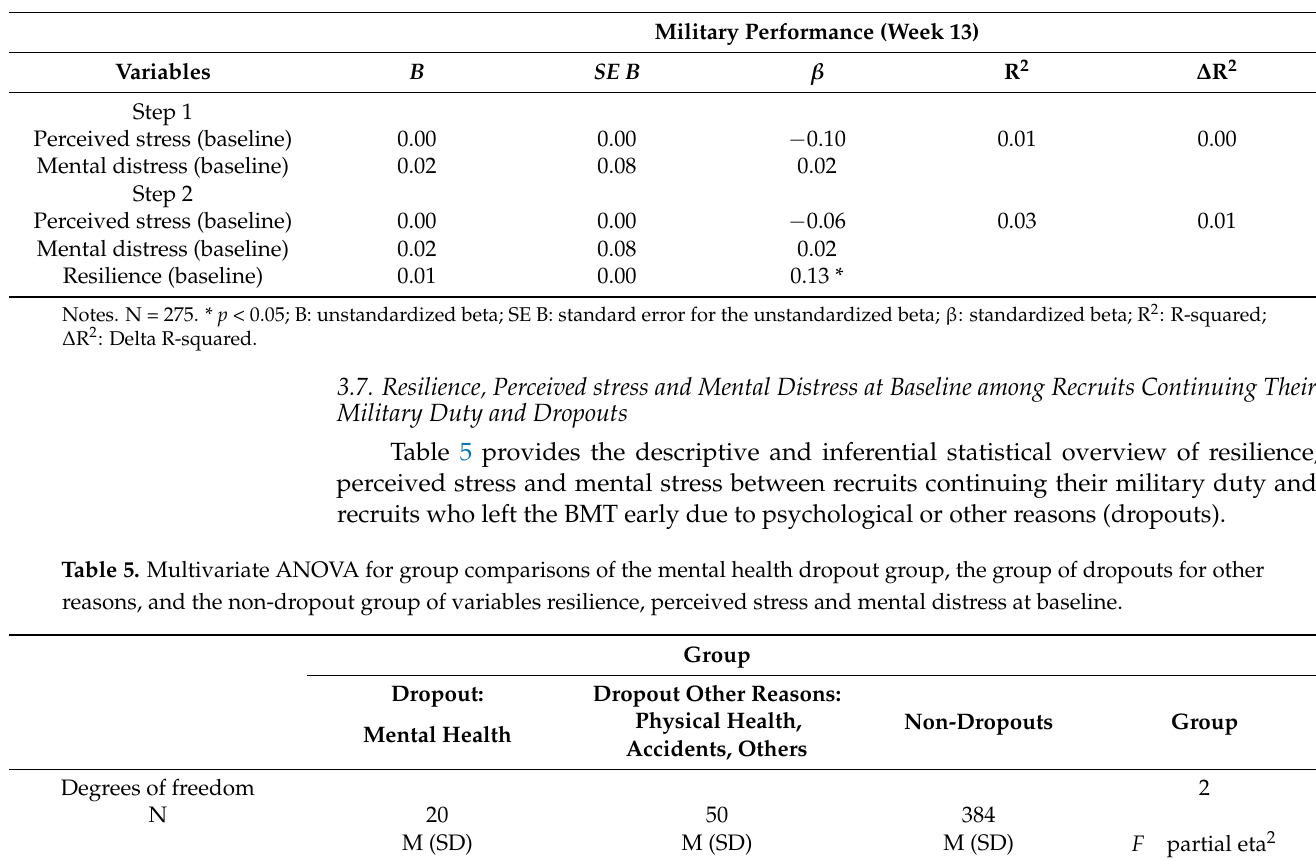
Table 4. The influence of resilience (baseline) on military performance at week 13 in a hierarchical regression analysis, controlling for baseline values of perceived stress and mental distress.